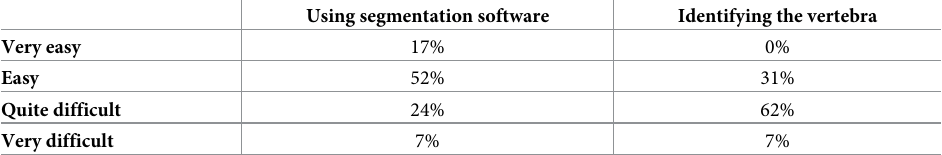
Table 1. Participant evaluation. Distribution of participants (n = 29) rating the difficulty of using the segmentation software tools and identifying the vertebra in the